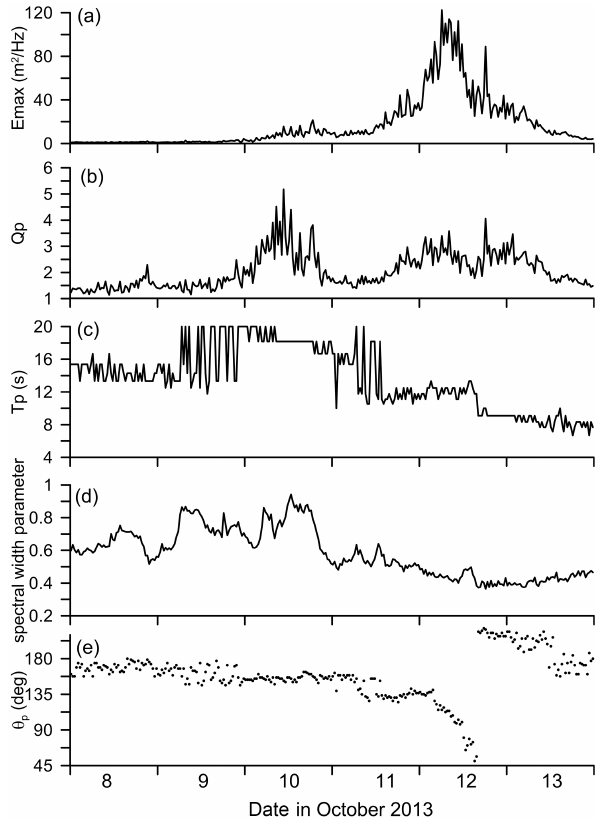
Figure 12. Variation of (a) maximum spectral energy density, (b) spectral peakedness parameter, (c) peak wave period, (d) spec- tral width parameter and (e) mean wave direction during 8–13 Oc- tober 2013.